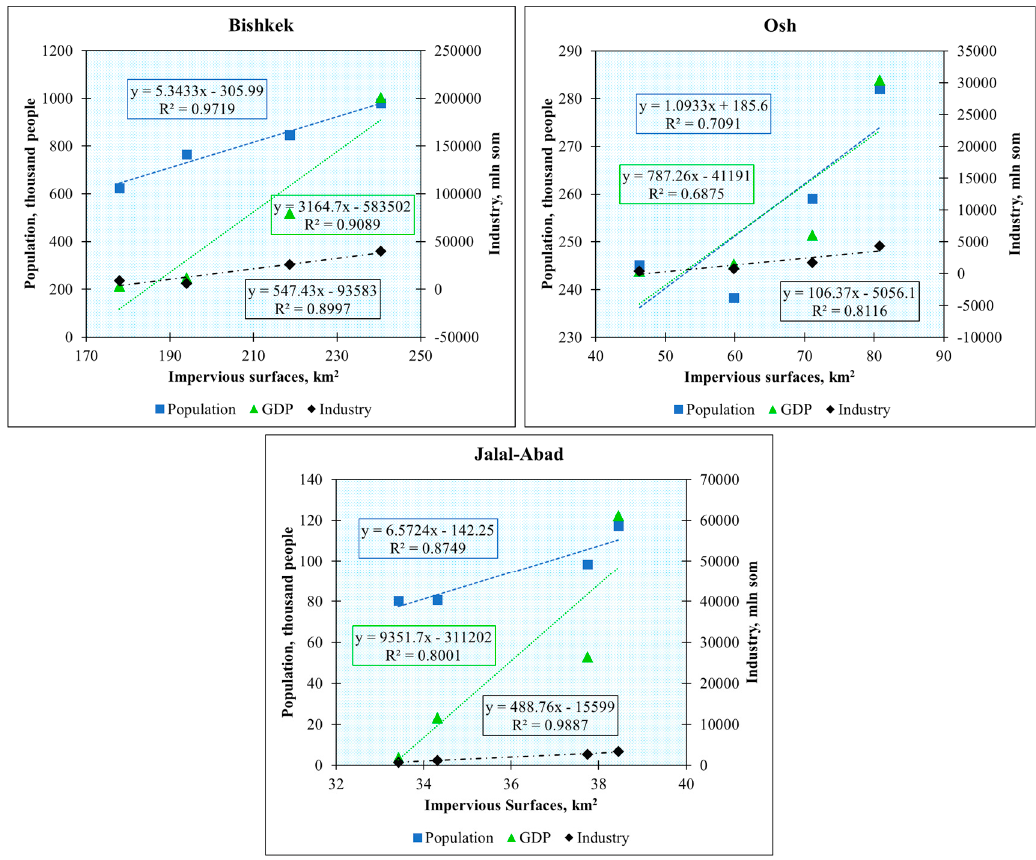
Figure 10. Correlation between impervious surface changes and population, gross domestic product (GDP), and industrial changes for the period 1993–2017.